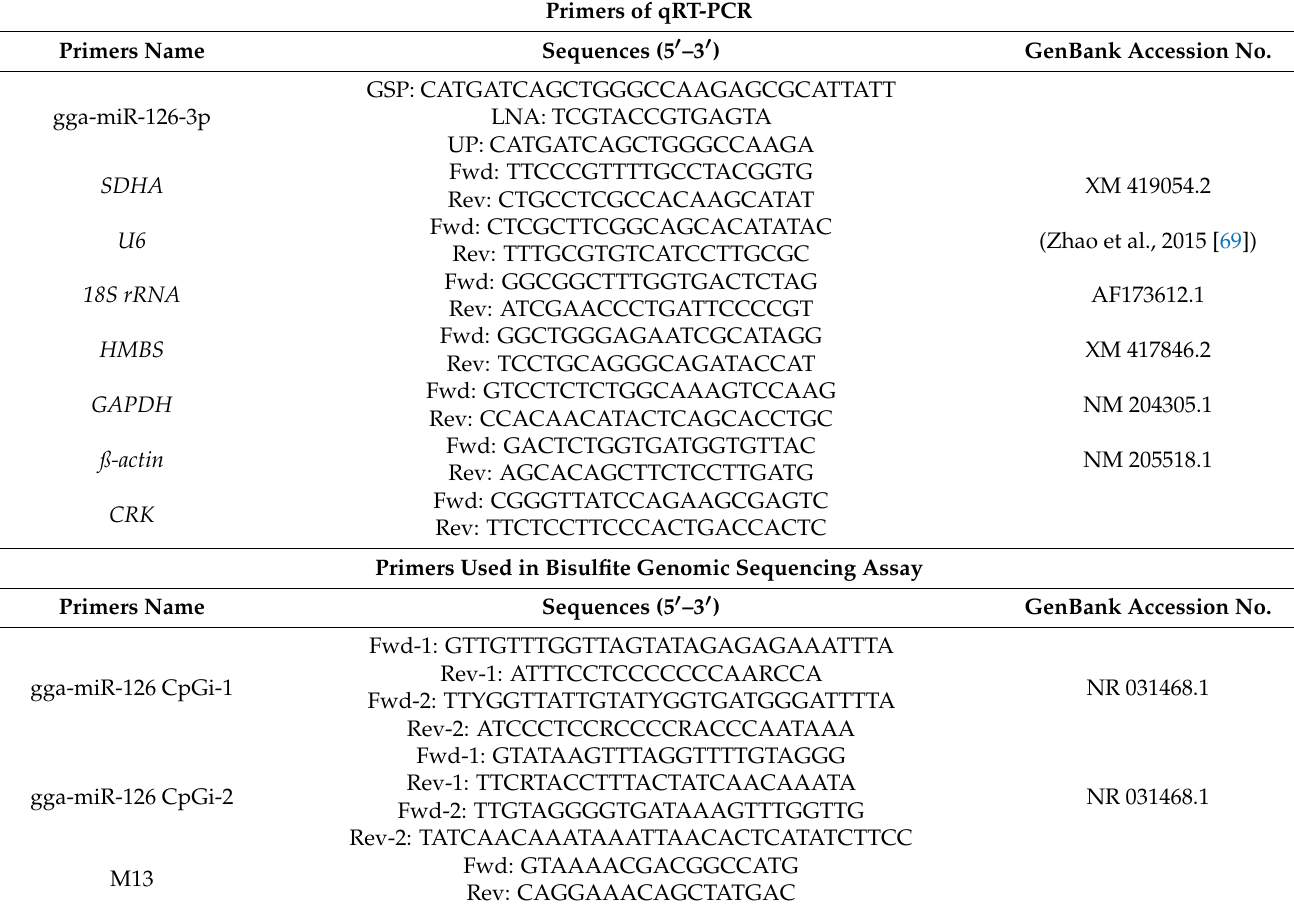
Table A1. Information for primers. Gallus gallus (gga), Gallid alphaherpesvirus-2 (GaHV-2), gene-specific primer (GSP), locked nucleic acid (LNA), universal primer (UP), forward primer (Fwd), reverse primer (Rev), CpGi means CpG island. When nested PCR was performed, Fwd and Rev primers were numbered: number 1 means the primer was used for the first PCR reaction and number 2 means the primer was used for the nested PCR reaction. R stands for purine, a G or A nucleotide. Y stands for pyrimidine, a C or T nucleotide. Bold and italic letters are the restriction site of Pme I restriction